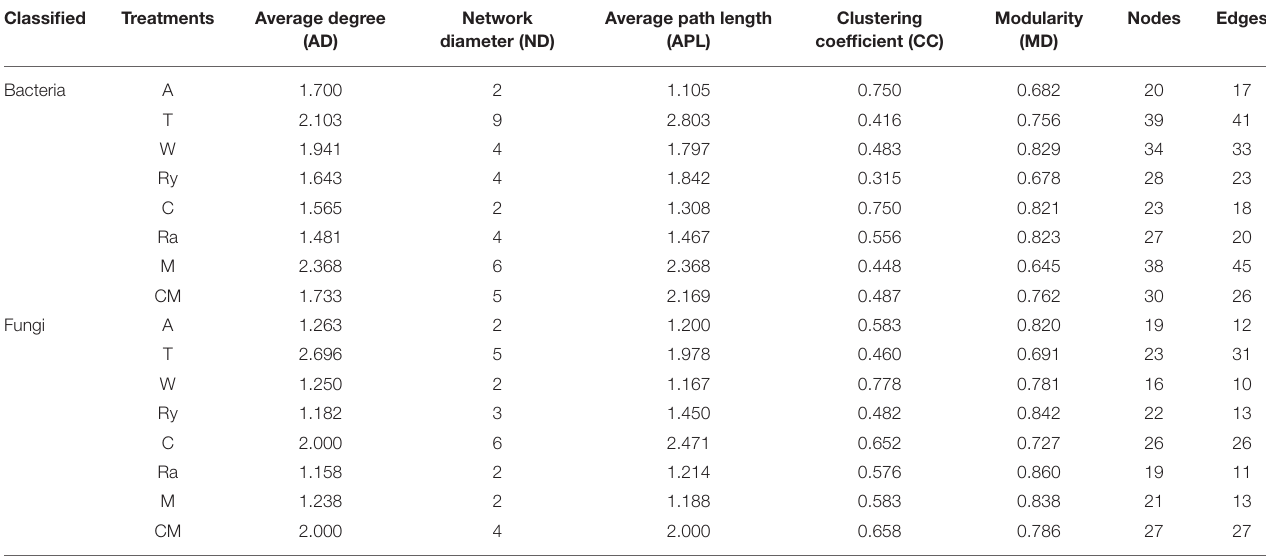
Network Average path length (AD) diameter (ND) (APL)